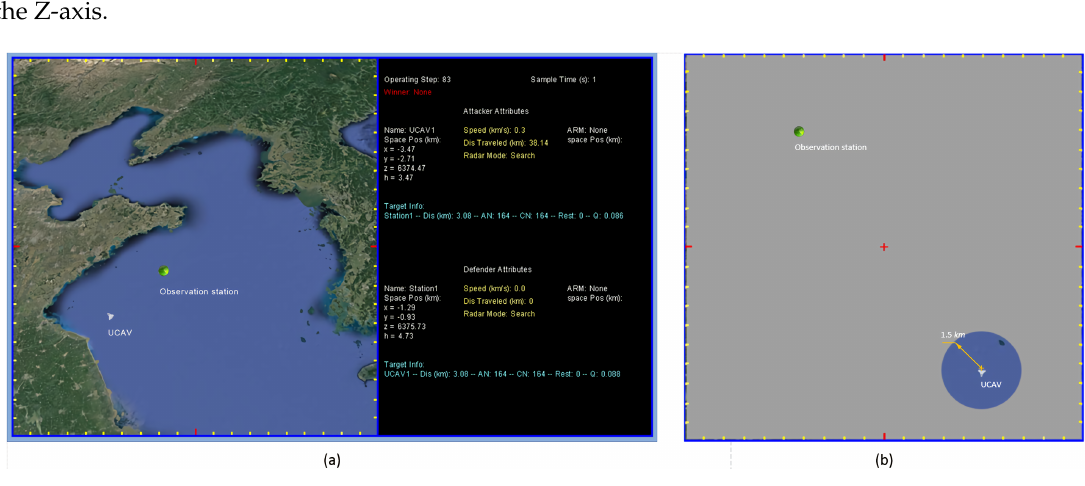
600 × 600 panel on the left side displays the map from the global perspective, and the 600 × 450